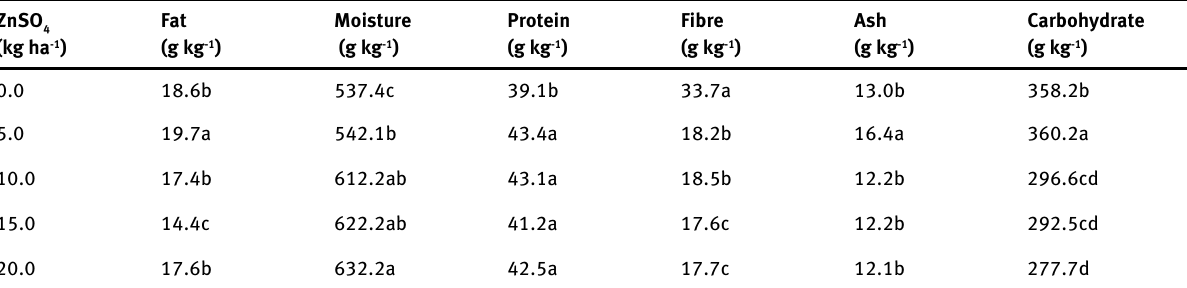
fertilizer on the proximate quality of sweet potato (mean from 2015 and 2016) Table 4: Effect of ZnSO 4 ZnSO Fat 4 (kg ha -1 ) (g kg -1